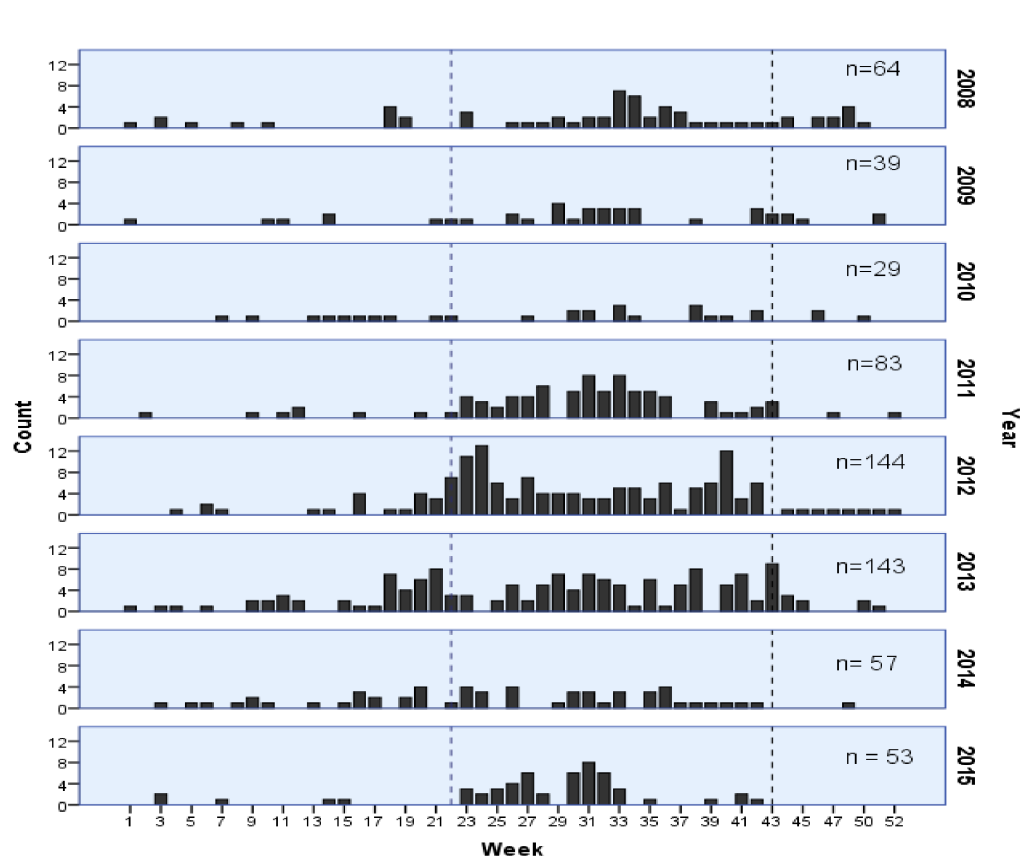
Fig 2. Annual cases of cutaneous anthrax by week in the year in Georgia (EIDSS 2008–2015). Variation in weekly counts of disease occurrence and shifts in seasonal cycles are presented on the figure.